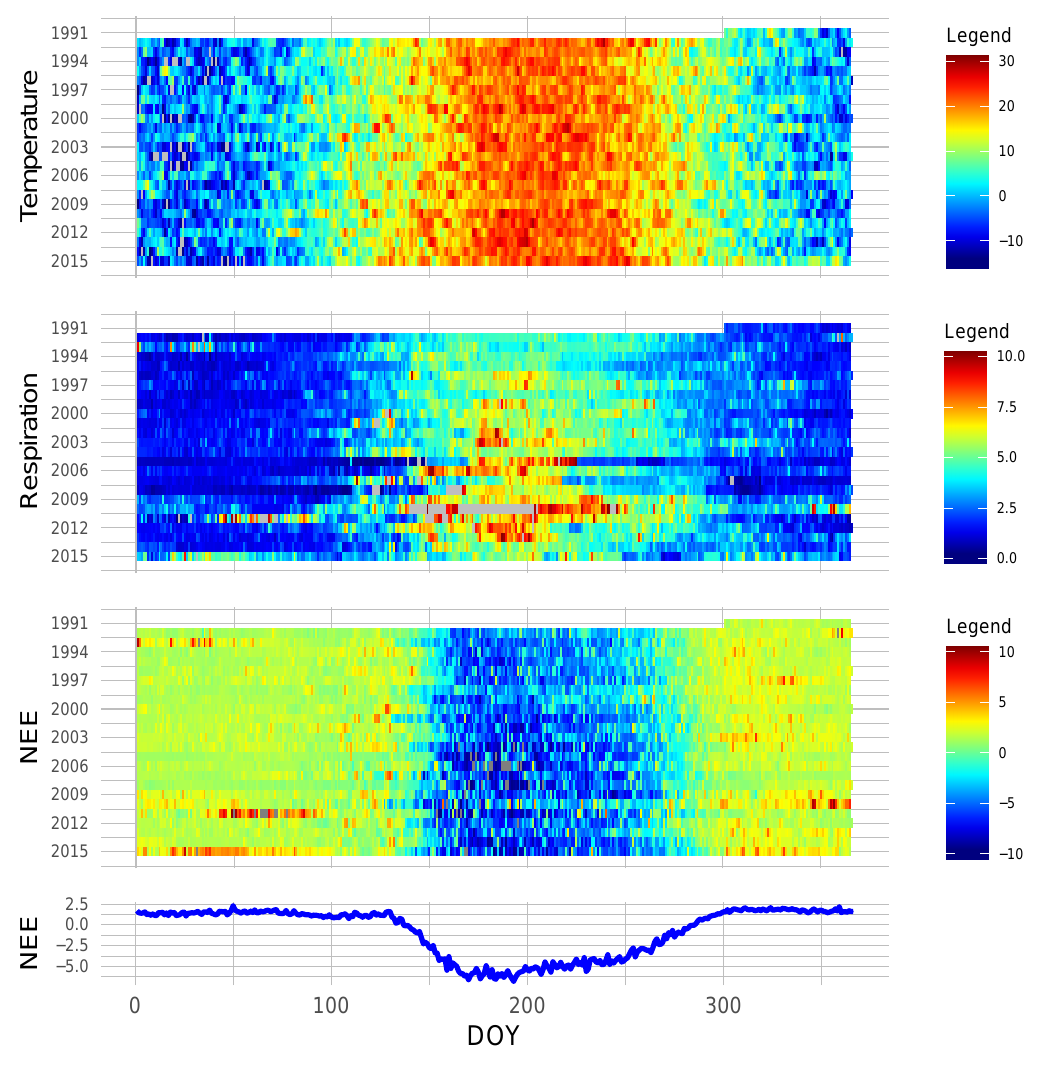
Figure A1. HF-EMS tower daily